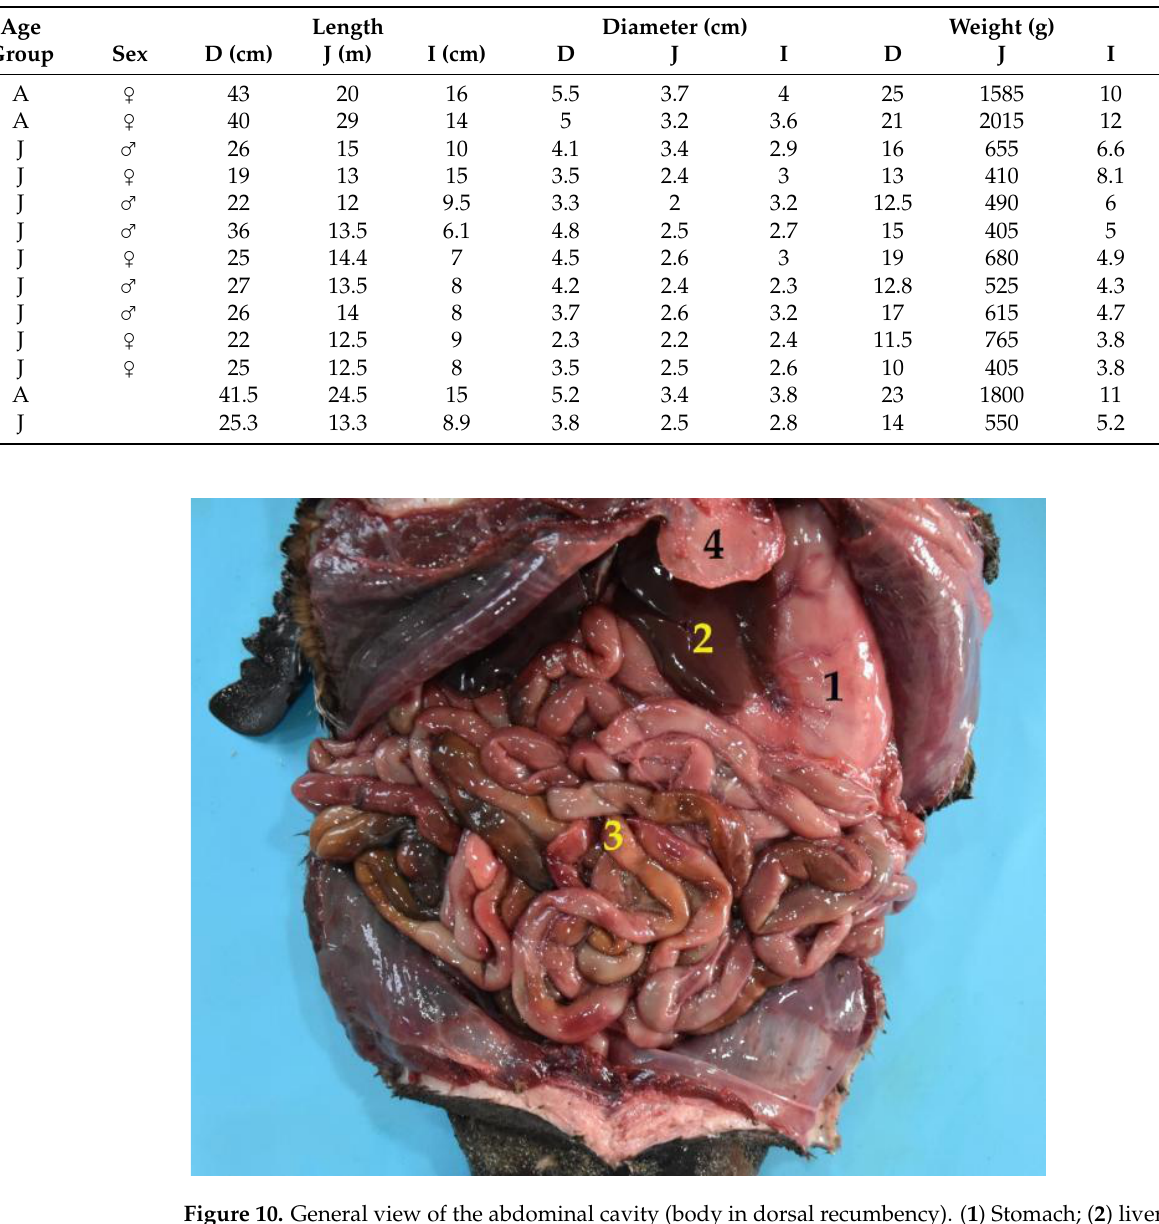
Table 4. Morphometric data of the small intestine proceeding of the 11 specimens of Arctocephalus australis used in the present study. A: adult; J: juvenile; D: duodenum; J: jejunum; I: ileum.